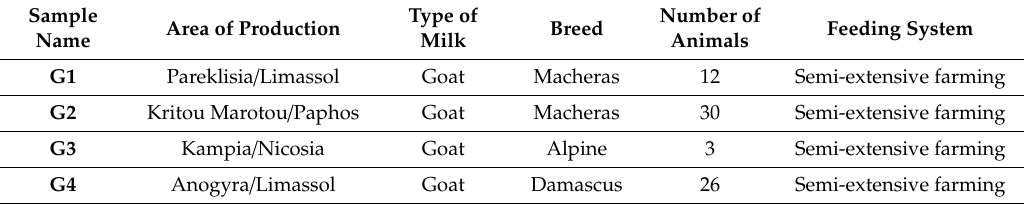
Table 1. Information regarding the milk samples used in the present